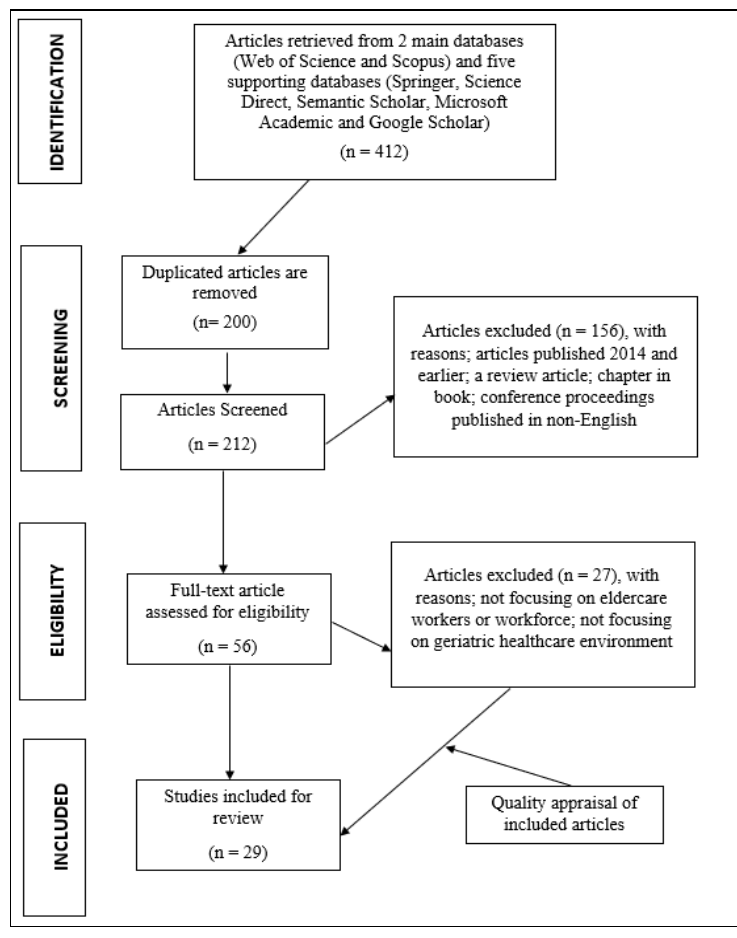
Figure 1. ROSES flow diagram of the searching process (Adapted from [21,22]).